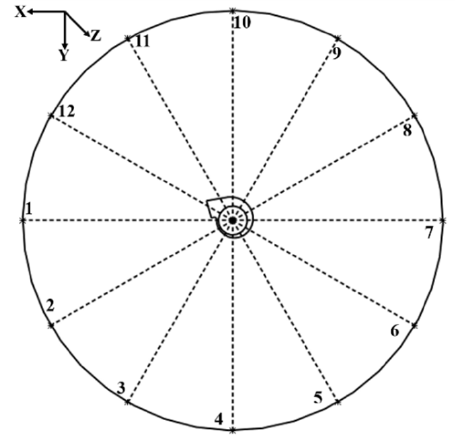
Figure 19. Noise monitoring points.